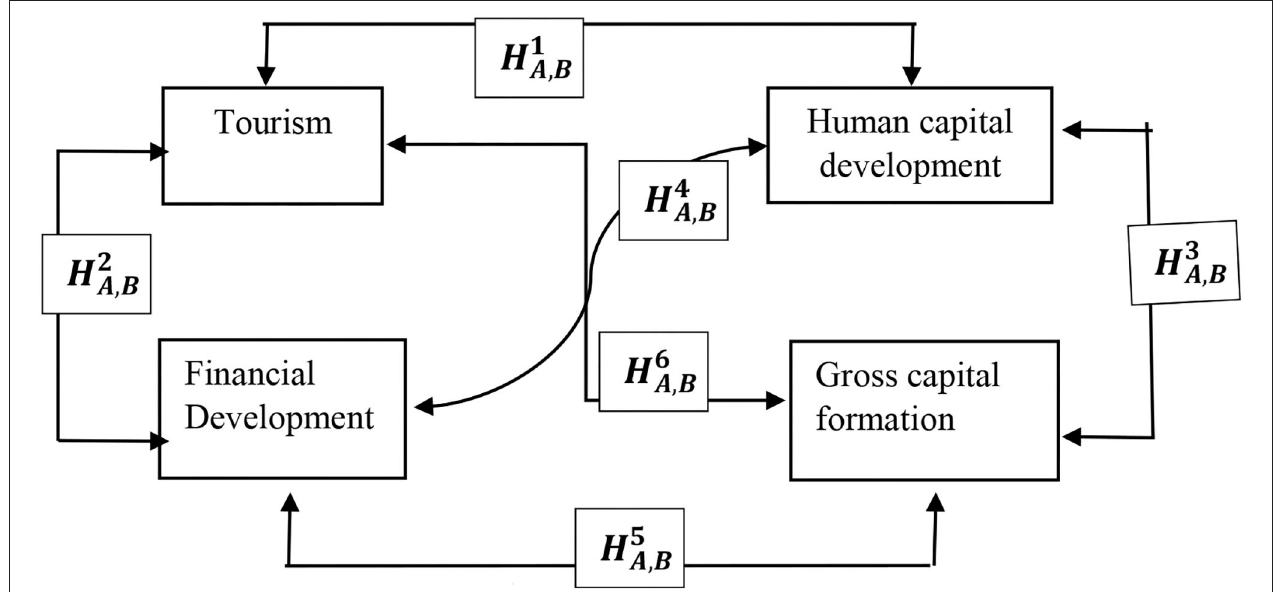
FIGURE 1 | Conceptual model and hypothesis of the